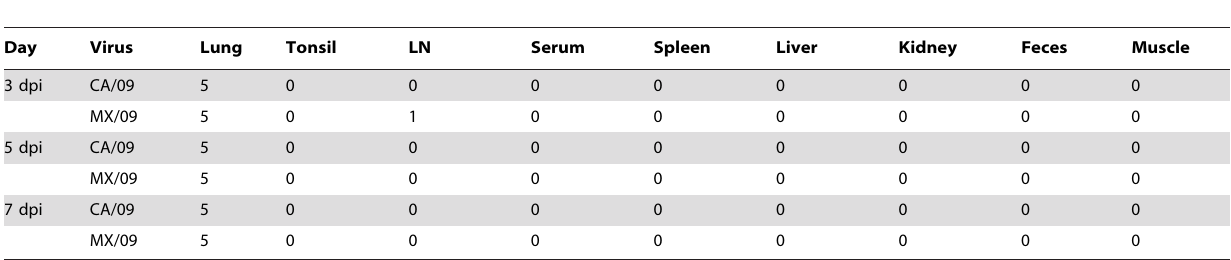
Table 2. Presence of pandemic H1N1 influenza virus by qRT-PCR in samples collected at 3, 5, and 7 days post infection (dpi). *